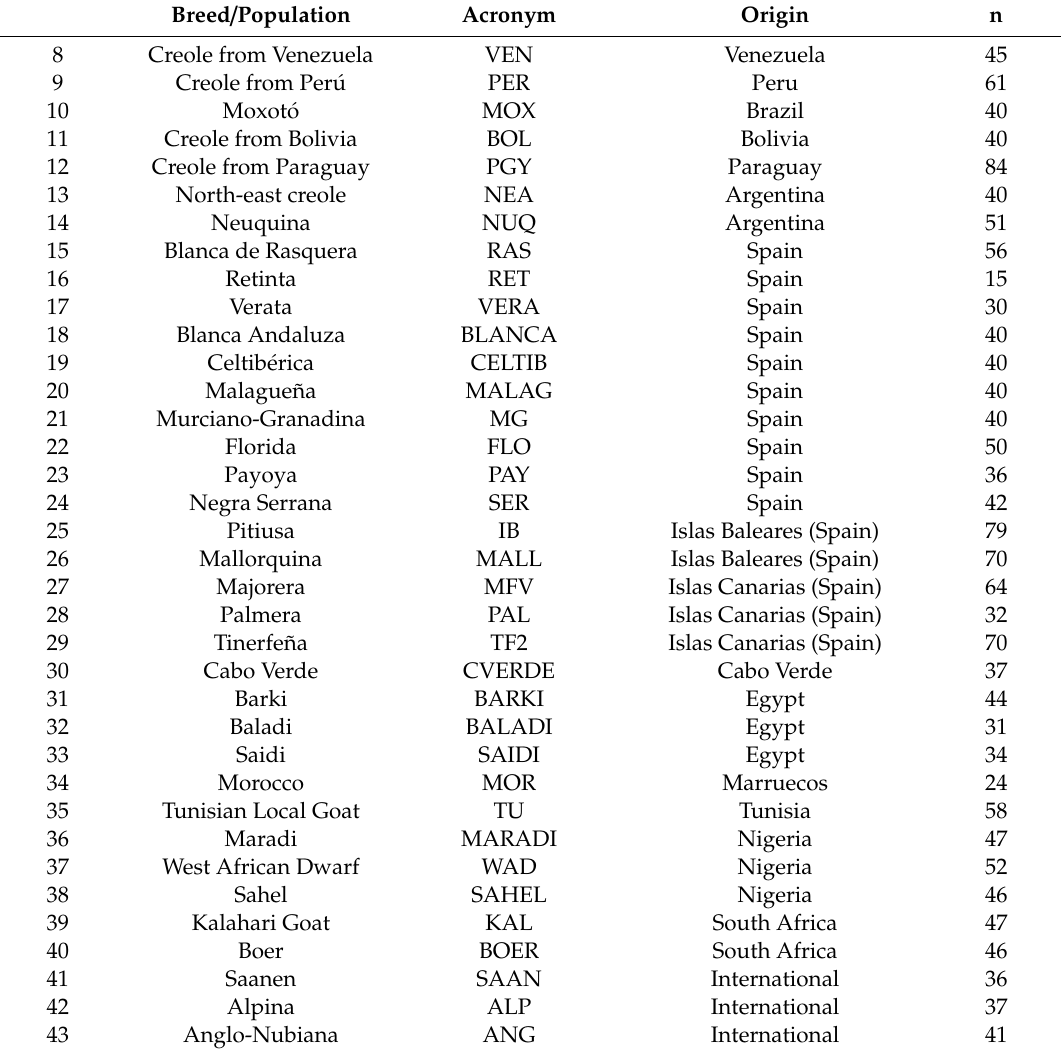
or heterozygosity. In Table 2, the values of expected mean heterozygosity (He = 0.706) and mean heterozygosity by direct count (Ho = 0.629) are shown. The value of F IS with a 95% confidence